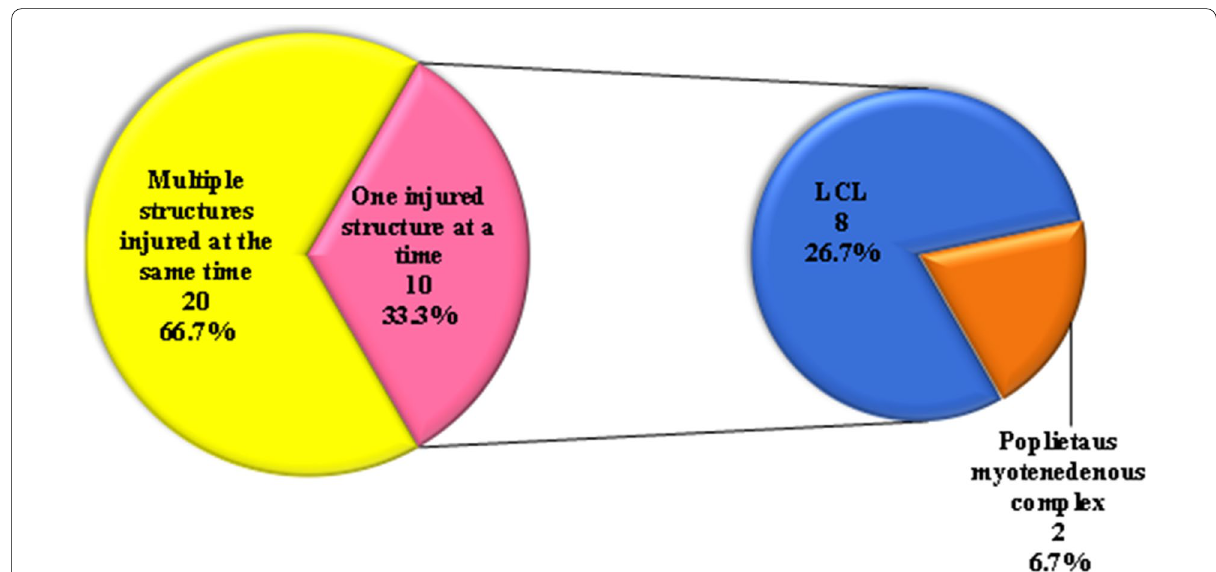
Fig. 1 Incidence of different single and multiple PLC corner structures injured in our studied cases